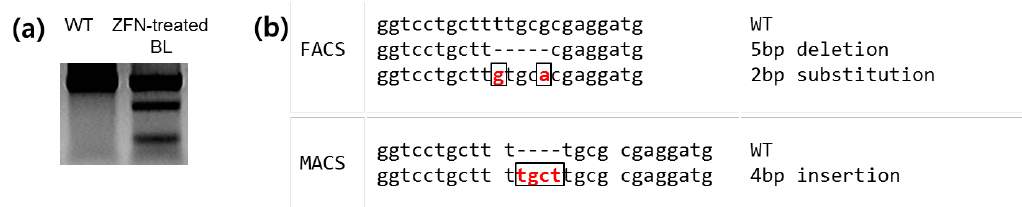
Figure 3. Mutations in cloned blastocysts derived from ZFN-treated cells. (a) The T7e1 assay showed ZFN-mediated mutations in cloned blastocysts. (b) Genomic DNA sequences from the cloned blastocyst.